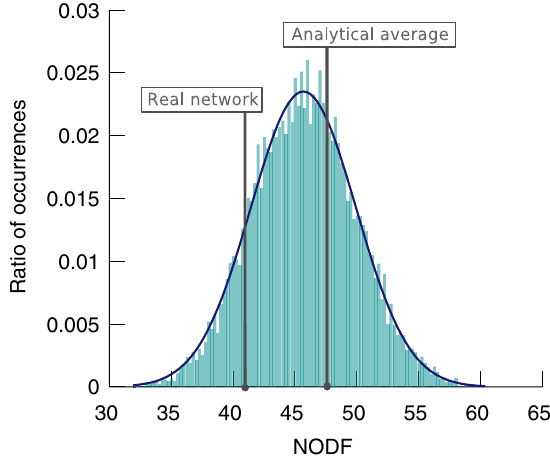
FIG. 4. Nestedness distribution for a sampling of the statistical ensemble corresponding to the empirical networks by Small [50]. In blue, the fit of a Gaussian function using the mean and standard deviation extracted from the distribution (mean μ ¼ 45 . 8 and standard deviation σ ¼ 4 . 2 ).Ingray,thevaluesofthenestednessof the real network and of the analytical average, which correspond to the average computed using the analytical expression in Eq.